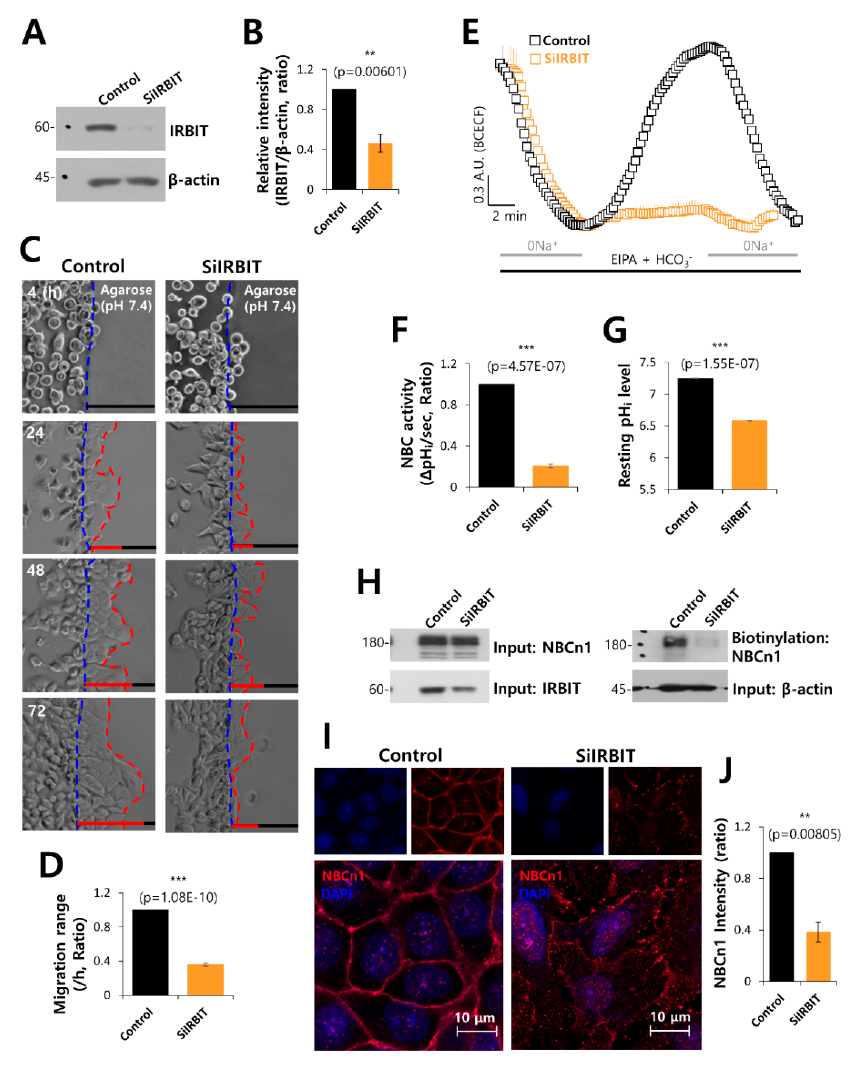
Figure 3. IRBIT knockdown decreased cell motility and NBC activity. ( A ) Protein expression of IRBIT in the presence of SiRNA-IRBIT (SiIRBIT) in A549 cells. β -Actin was used as loading